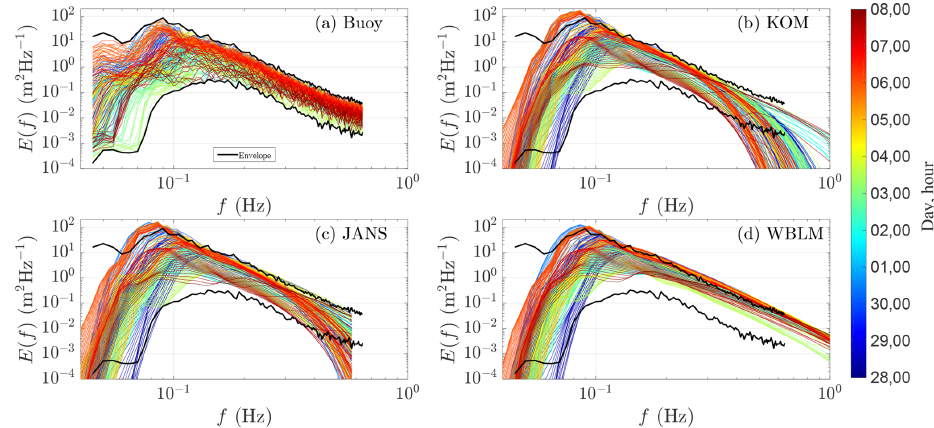
Figure 8. One-dimensional wave spectrum from buoy measurements at RUNE with all available data during the two storms (a) ; panels (b– d) are simulated with different source terms. The colors of the lines represent different times. The black solid lines in each panel are the envelope lines to mark the upper and lower bounds of the measurement